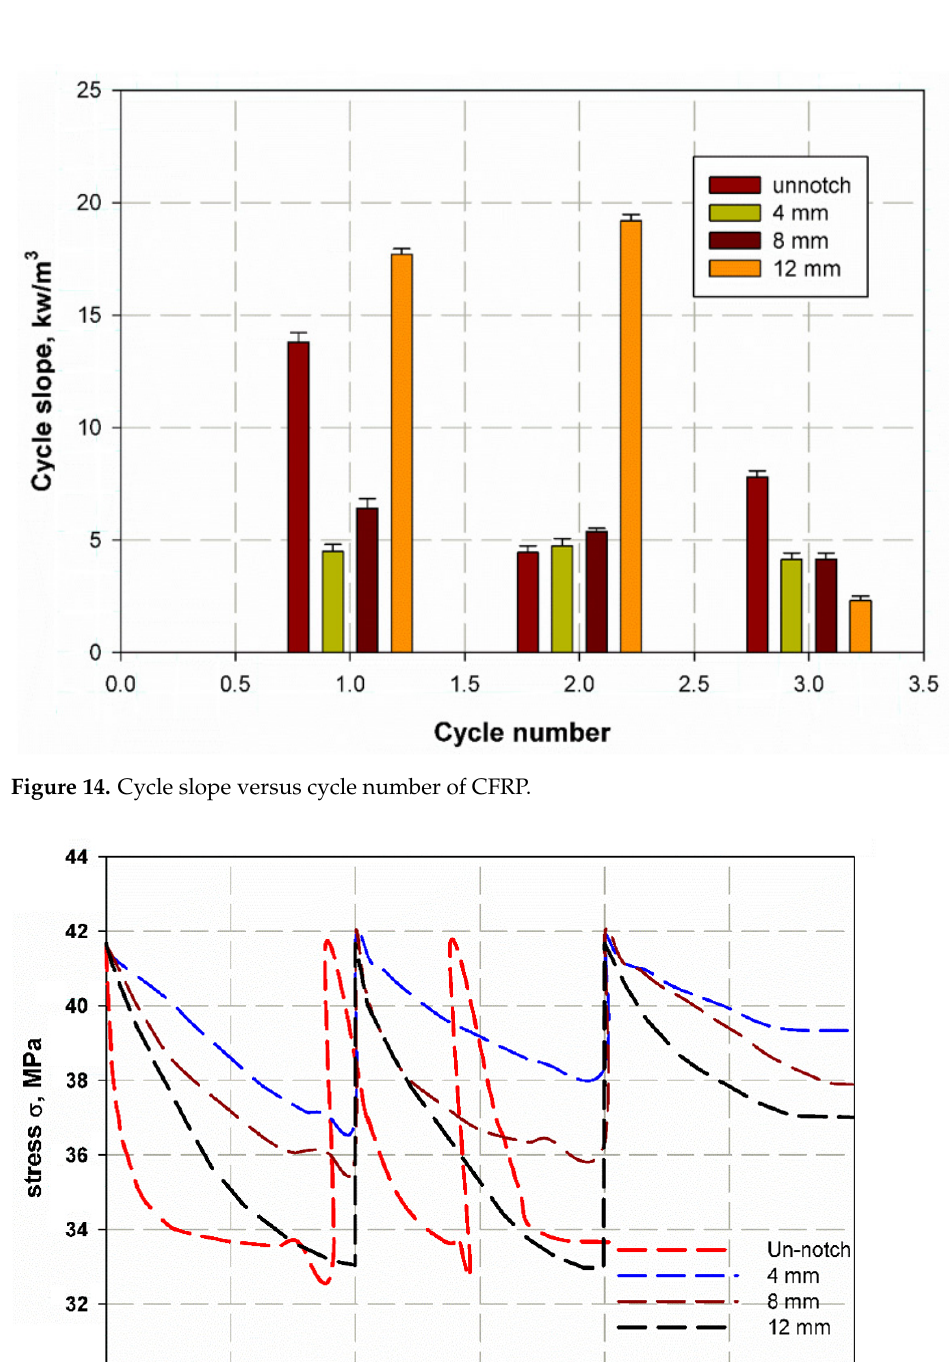
Figure 13. Relaxation stress and time curve of CFRP.